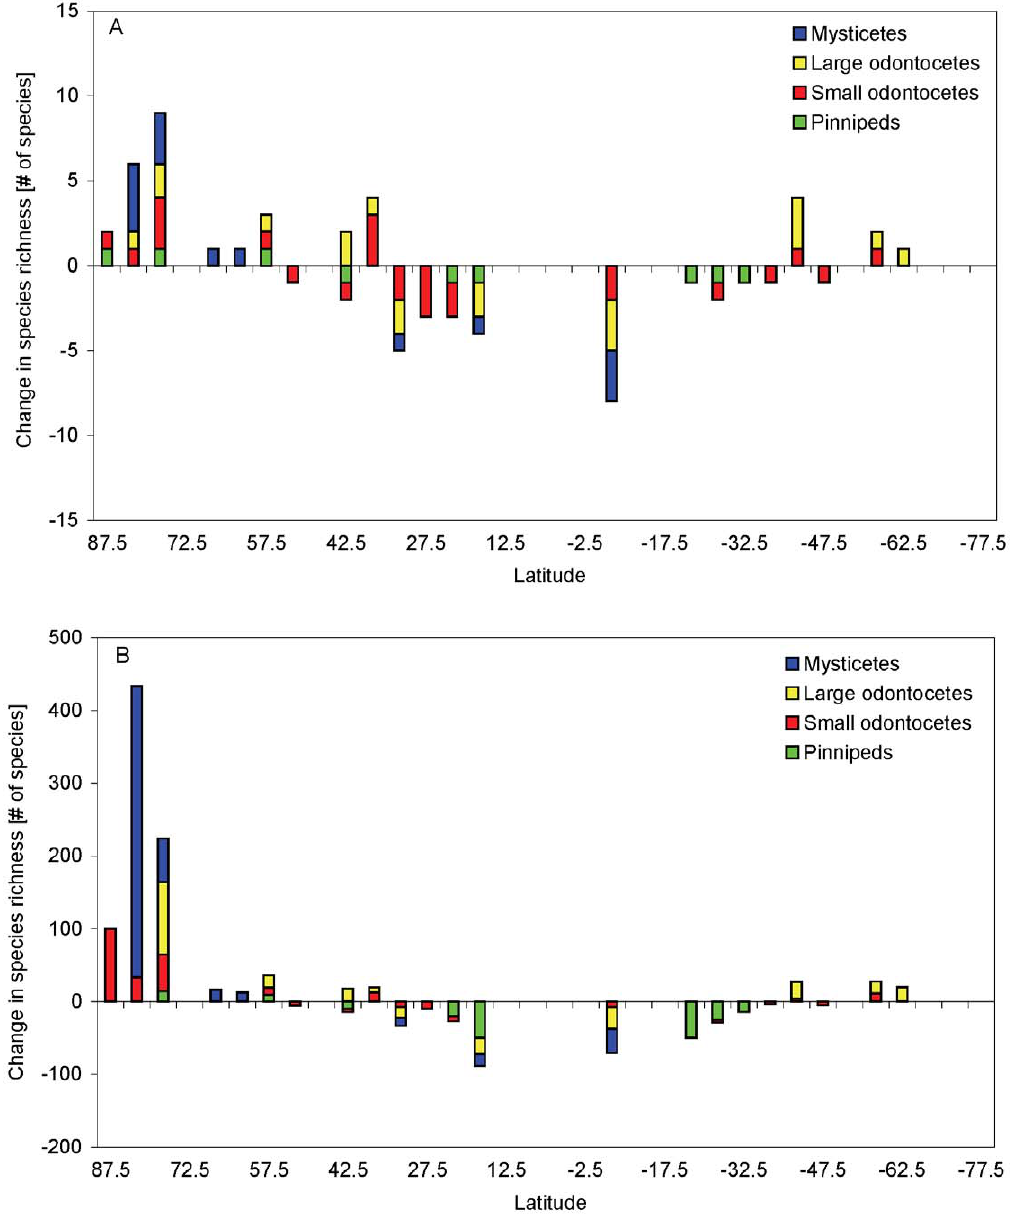
Figure 6. Projected absolute and proportional changes in marine mammal species richness and community composition at different latitudes. Changes were calculated relative to predicted species richness for the 1990s summed over 5 u latitudinal bands for mysticetes, small odontocetes, large odontocetes, and pinnipeds.